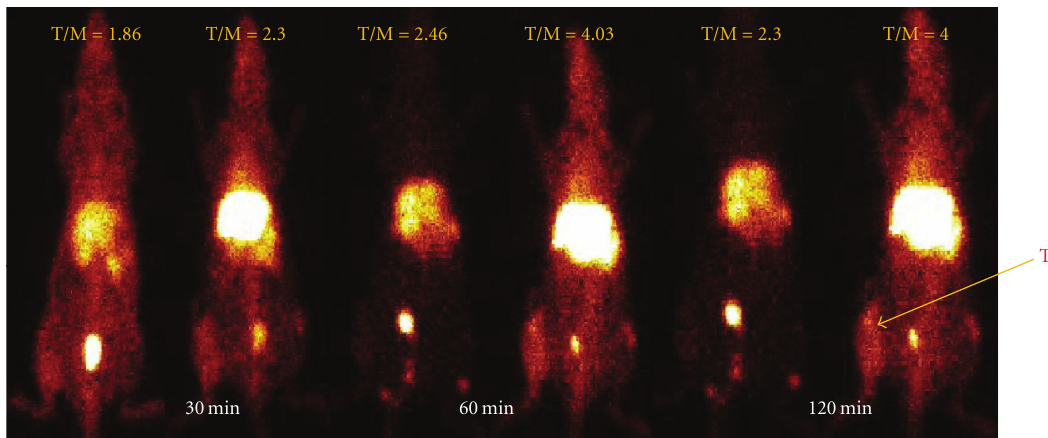
Figure 4: Planar scintigraphic imaging studies of 99m Tc-N 4 -AMT. Scintigraphic images of Fisher 344 tumor bearing rats were acquired, and computer outlined regions of interest (counts per pixel) in the tumors (T) and the symmetrical muscle tissues (M) were used to determine T/M count density